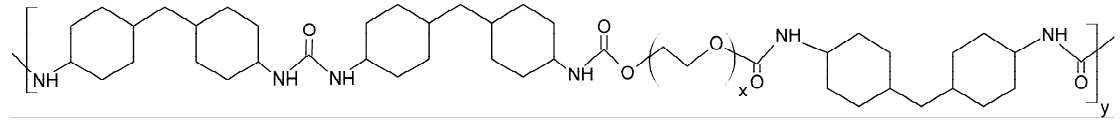
Figure 1. Chemical structure of Polyurethane/urea copolymers based on poly(ethylene glycol) (PURPEG) polymer.